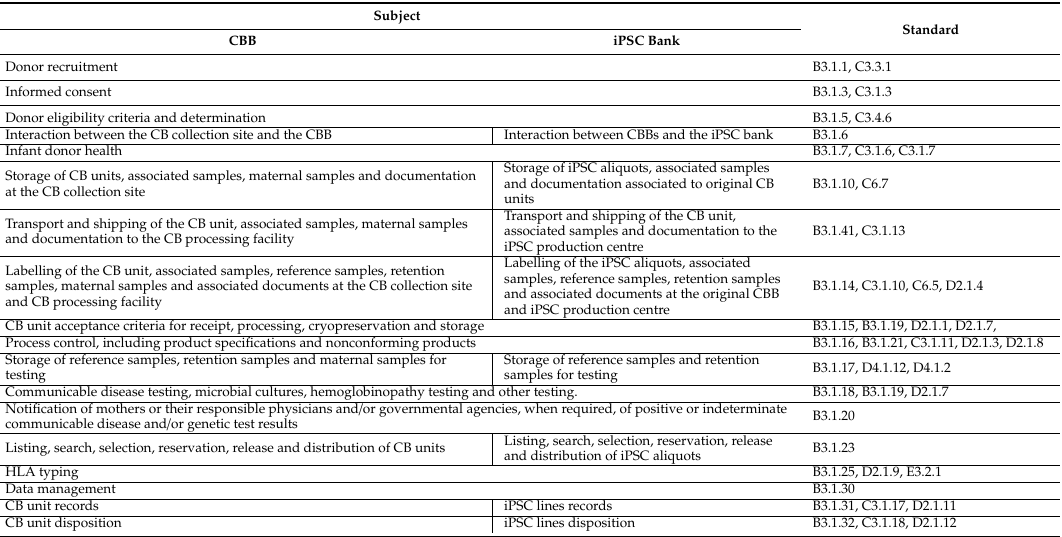
Table 1. Possible adaptation of required Policies and SOPs from the NetCord-FACT International Standards for CB collection, banking and release for administration [20].